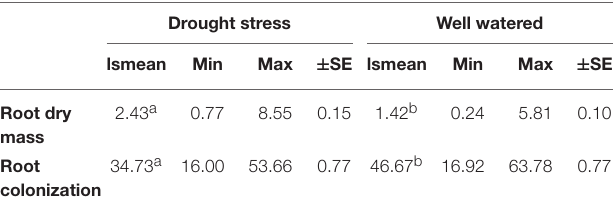
TABLE 1 | Least square means (lsmean), minimum (Min), maximum (Max), and standard error ( ± SE) for root dry mass (RM) and root colonization by